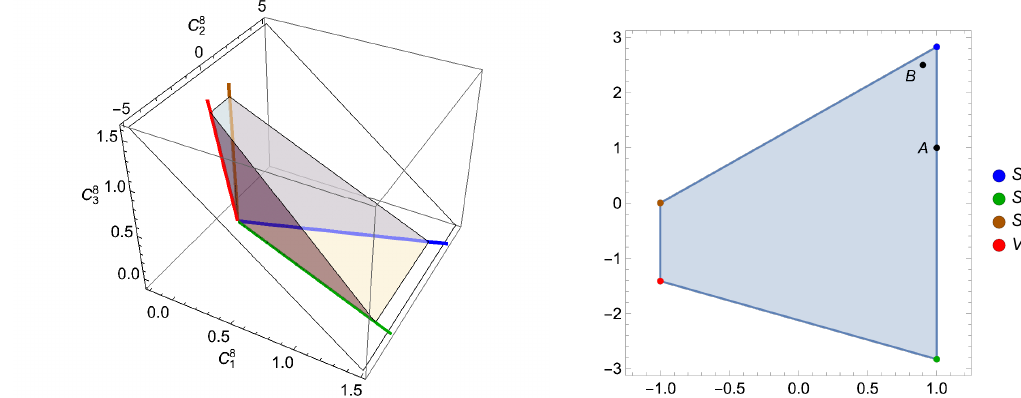
(cid:0) (cid:1) space, which is a pyramid. The edge C 8 , C 8 , C 8 1 2 3 √ + C = 2 (also shown in the left figure) 1 3